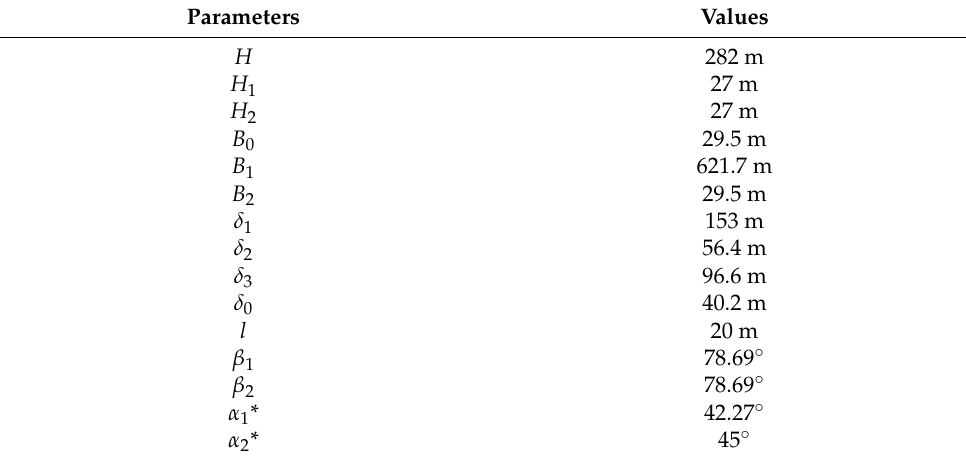
Table 6. Values of the corresponding parameters when the normal pool level is 2865.00 m a.s.l. and the downstream water level is 2610 m